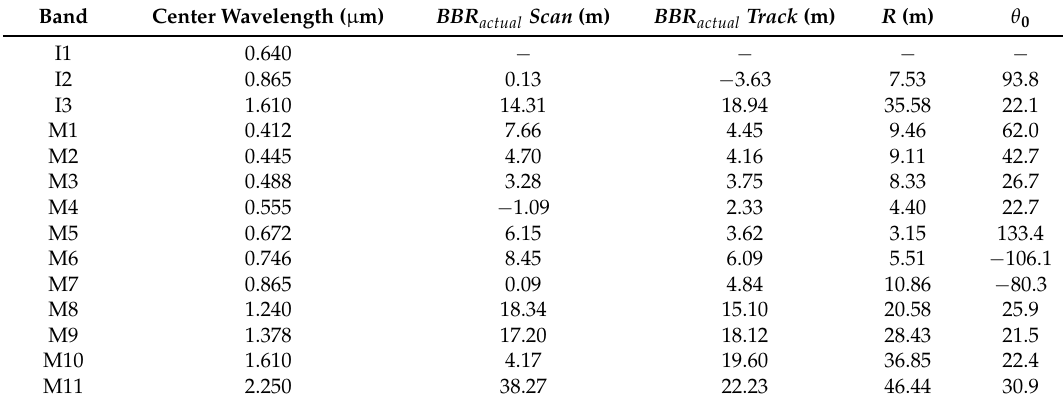
Figure 6. The trending of the instrumental parameters related to BBR characterization.